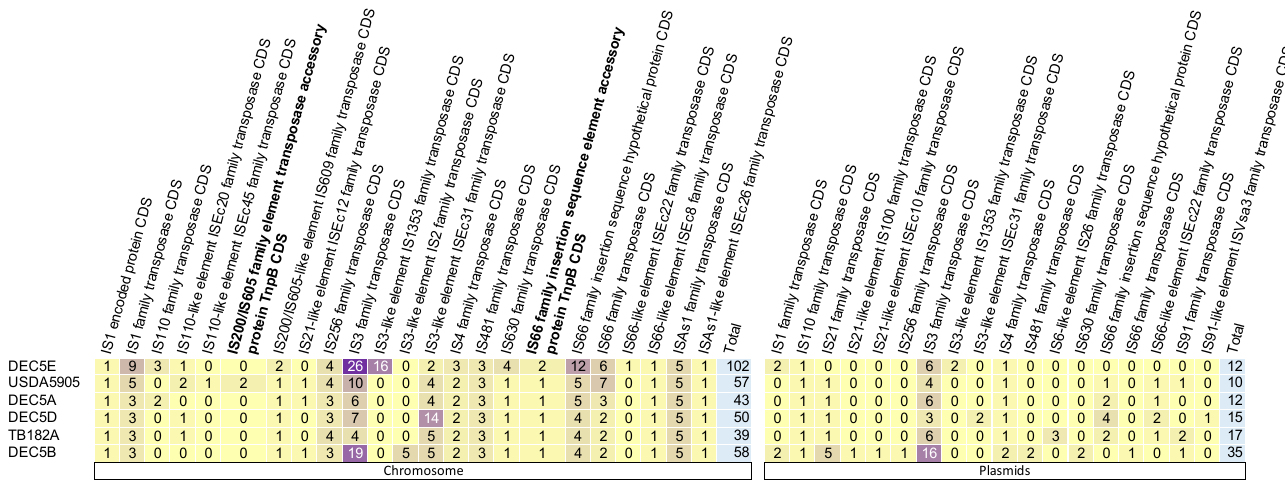
Figure 4. Heat map of insertion sequence (IS) elements in the chromosome and plasmids of six E. coli O55:H7. Plasmids are not broken down by individual plasmids; instead, all plasmids present in an isolate are aggregated into one. The strain names are on the y axis with the IS elements on the x axis. The number of copies of an IS element is represented by a different